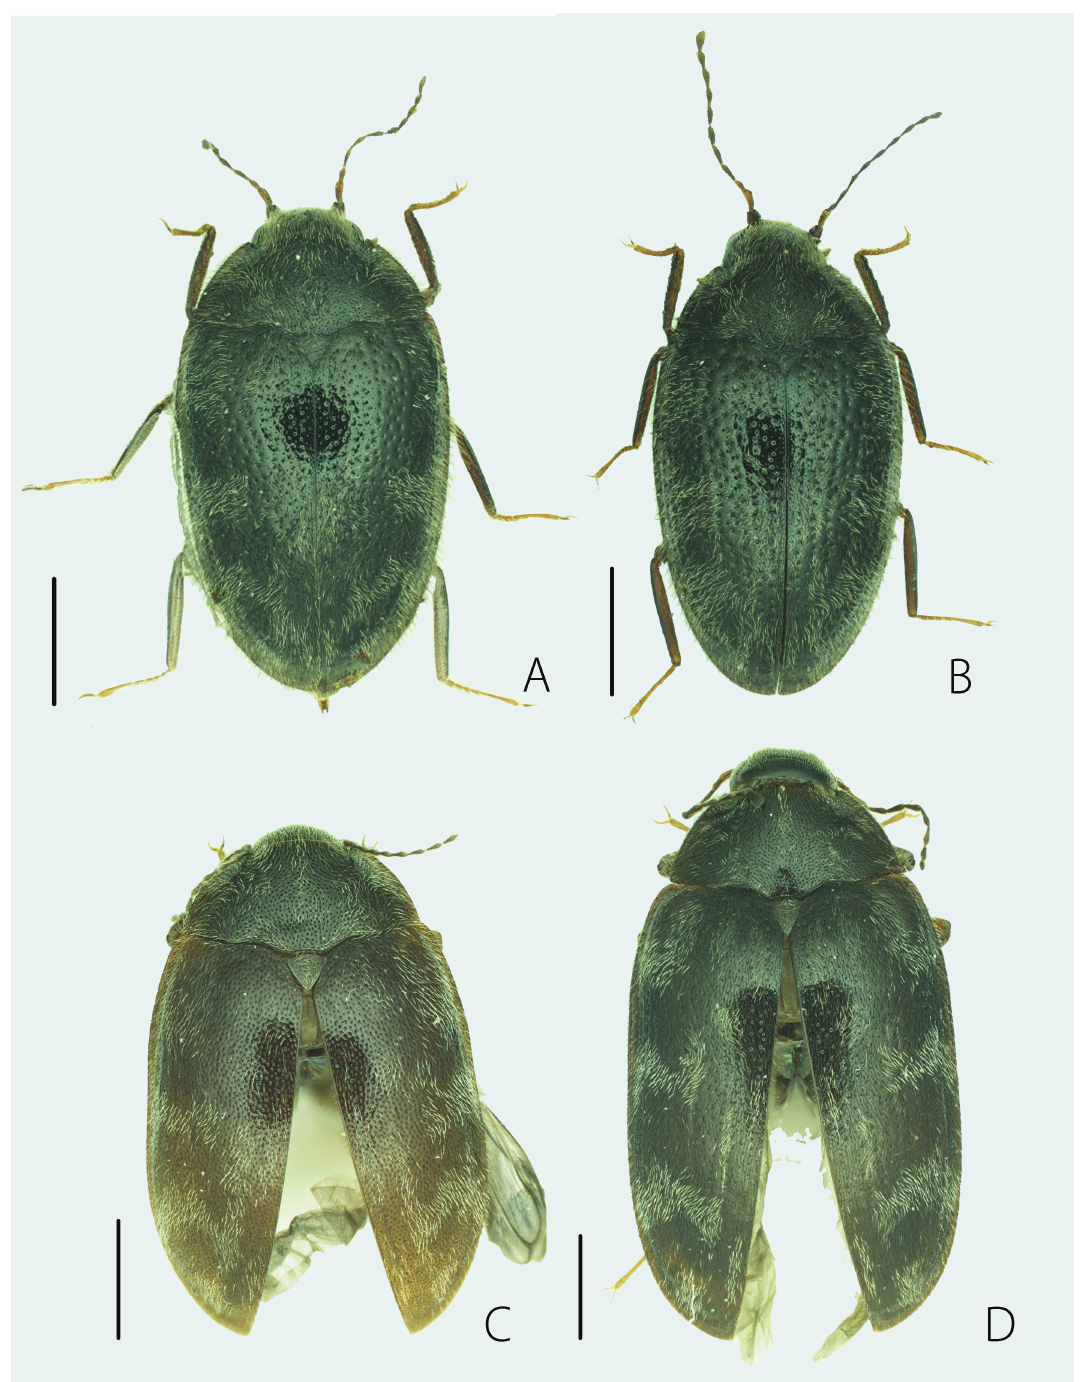
Fig. 1. Habitus of Caccothryptus spp., holotypes , ♂♂. A . Caccothryptus taiwanus sp. nov. B . C . orion sp. nov. C . C . tibetanus sp. nov. D . C . chayuensis sp. nov. Scales = 1.0